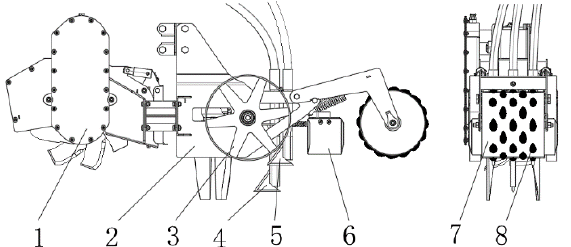
Figure 1. Structural diagrams of a wheat sowing unit with a non-smooth press roller. 1 . Primary rotary tillage system. 2. Secondary rotary tillage system. 3. Press roller. 4. Fertilizer shovel. 5. Opener. 6. Soil cover. 7. Smooth roller. 8. Double kink convex hull geometry.